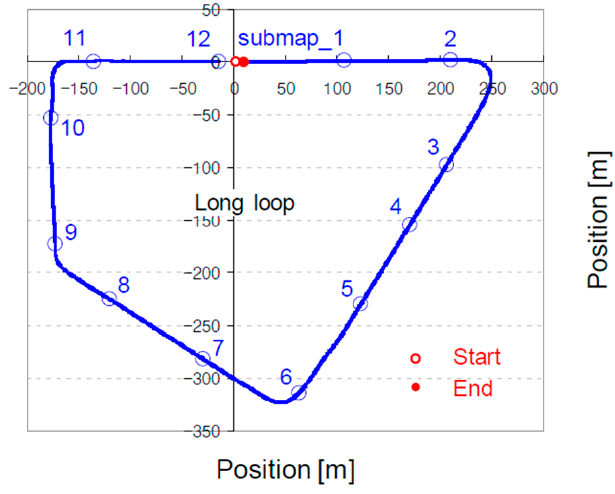
Figure 6. Progress of approximate_ndt_mapping inspected using the CSV file generated with PCD files.